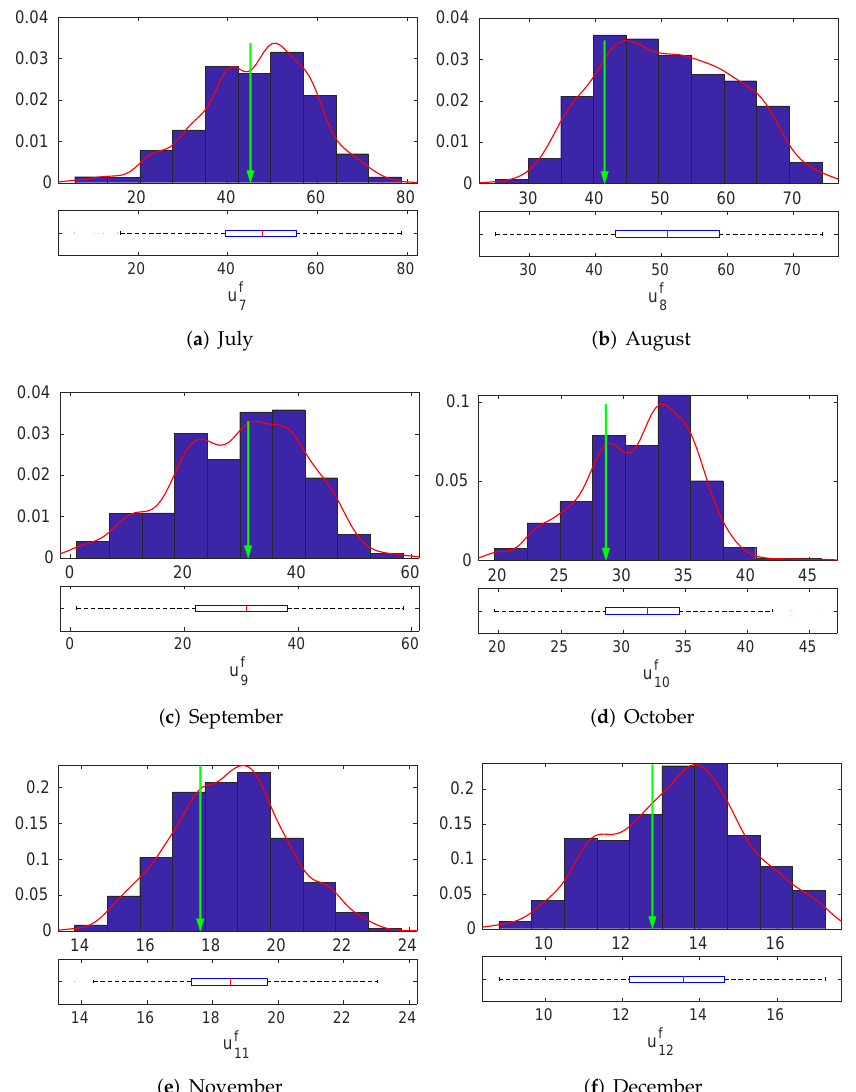
Figure 8. Distributions of the output LH associated to input parameters of CLM4 drawn by the a posteriori distributions: